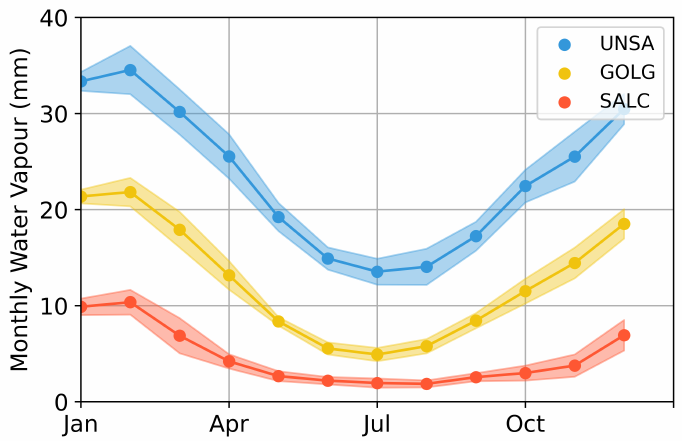
Figure 16. Mean monthly water vapour values for the stations along the topographic gradient from low to high elevations (cf. Figure 4). We analysed water vapour readings from 2010 to 2021 derived from ray tracing that only utilizes ERA5 meteorological data on pressure levels [38]. The semi- transparent colouring indicates the per-month standard